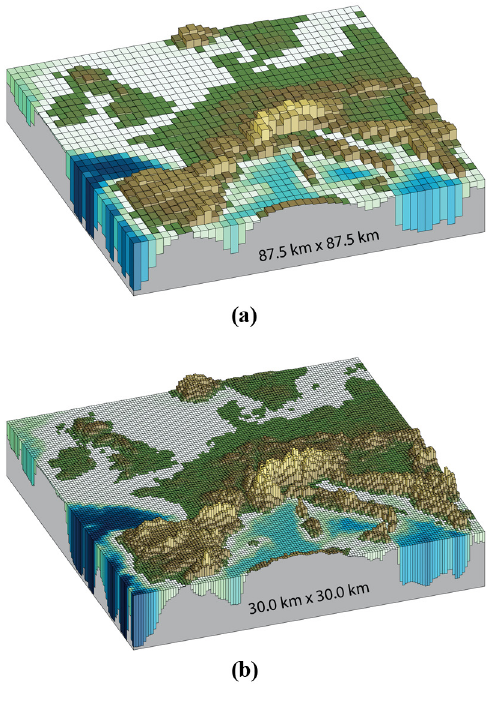
Figure 1. Horizontal resolutions considered in today ’ s higher resolution models and in very high resolution models now being